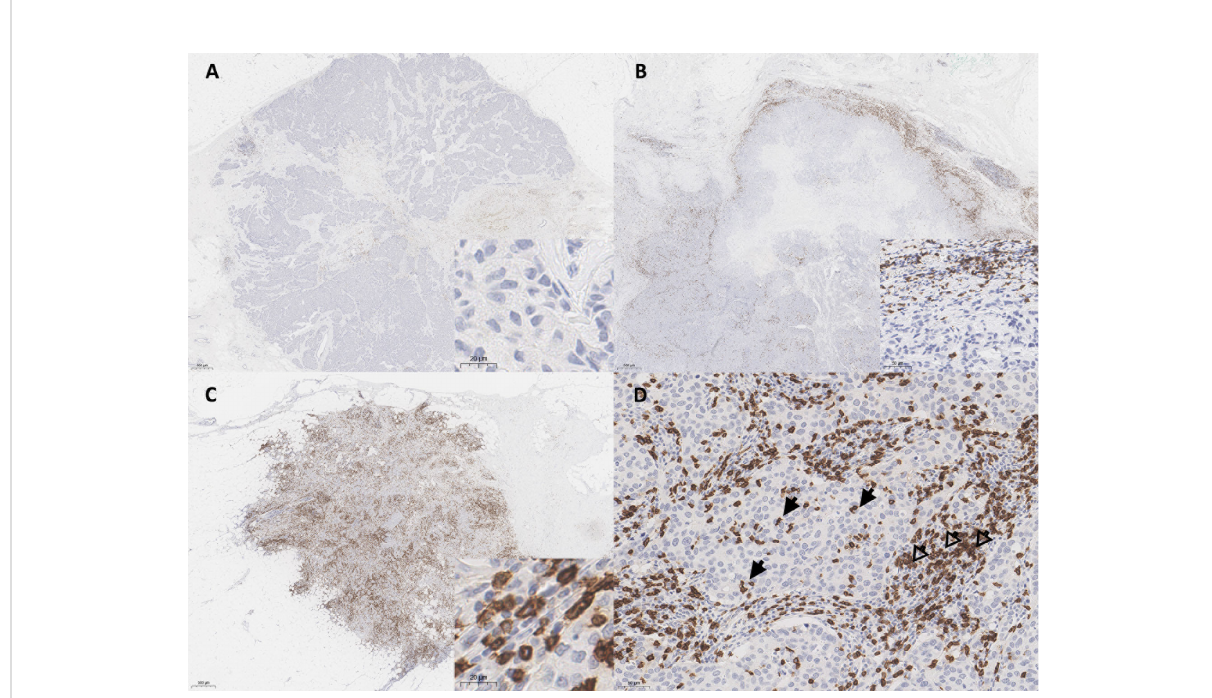
FIGURE 1 Representative whole slide images of CD8 + T cell spatial immunophenotypes in breast cancer; (A) immune-desert, (B) immune-excluded, and (C) immune-in fl amed. (D) In high power view, intratumoral tumor-in fi ltrating lymphocytes (TILs) (arrows) and stromal TILs (open arrows) are noted. The blue color is the hematoxylin counterstain. Original magni fi cation, A-C, scanning view D, ×200; inset, A, C, ×400, B,